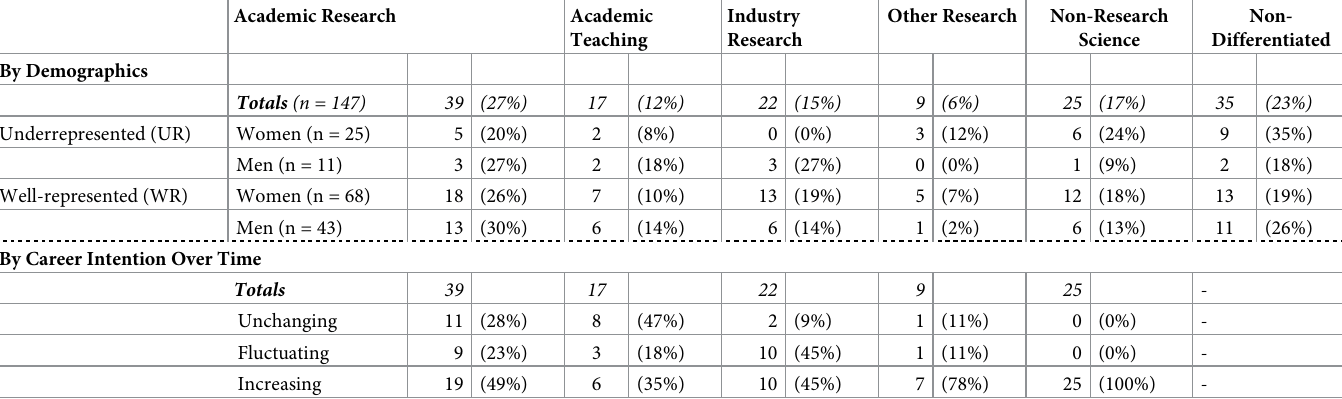
Table 1. Career intentions at